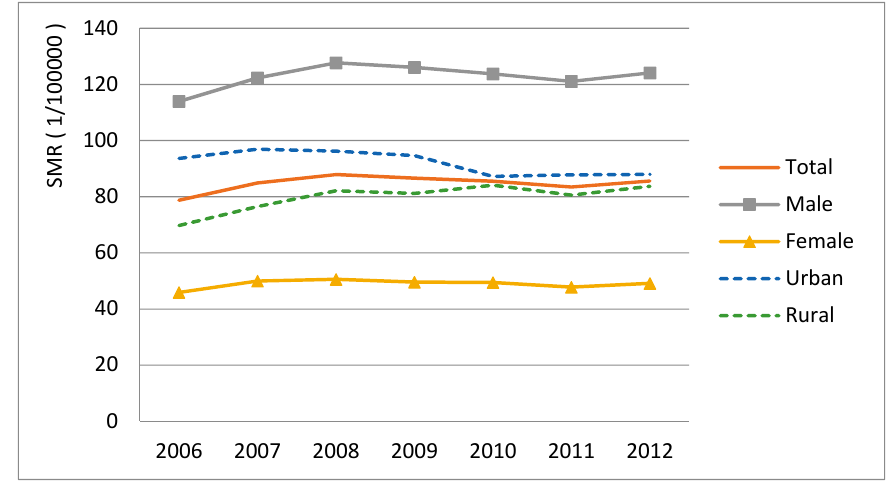
Figure 1. Lung cancer mortality trends during 2006–2012. SMR = Standardized mortality rate.